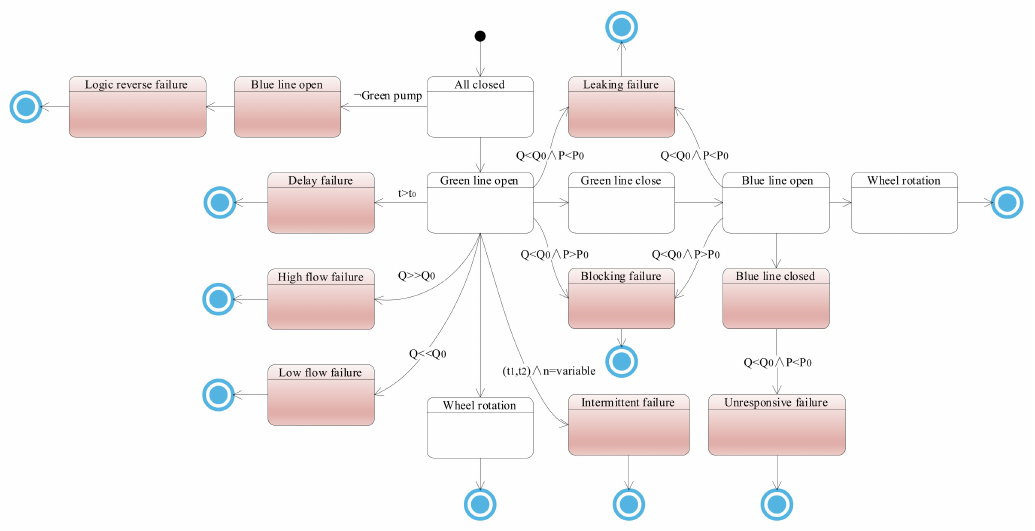
Figure 7. State machine diagram of selector valve module.